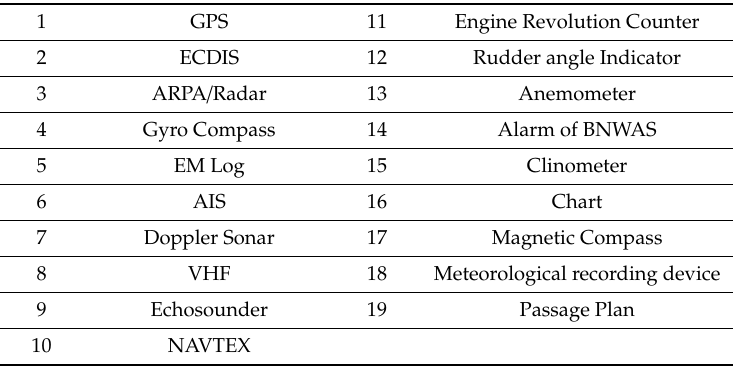
Table 3. Bridge navigation items.